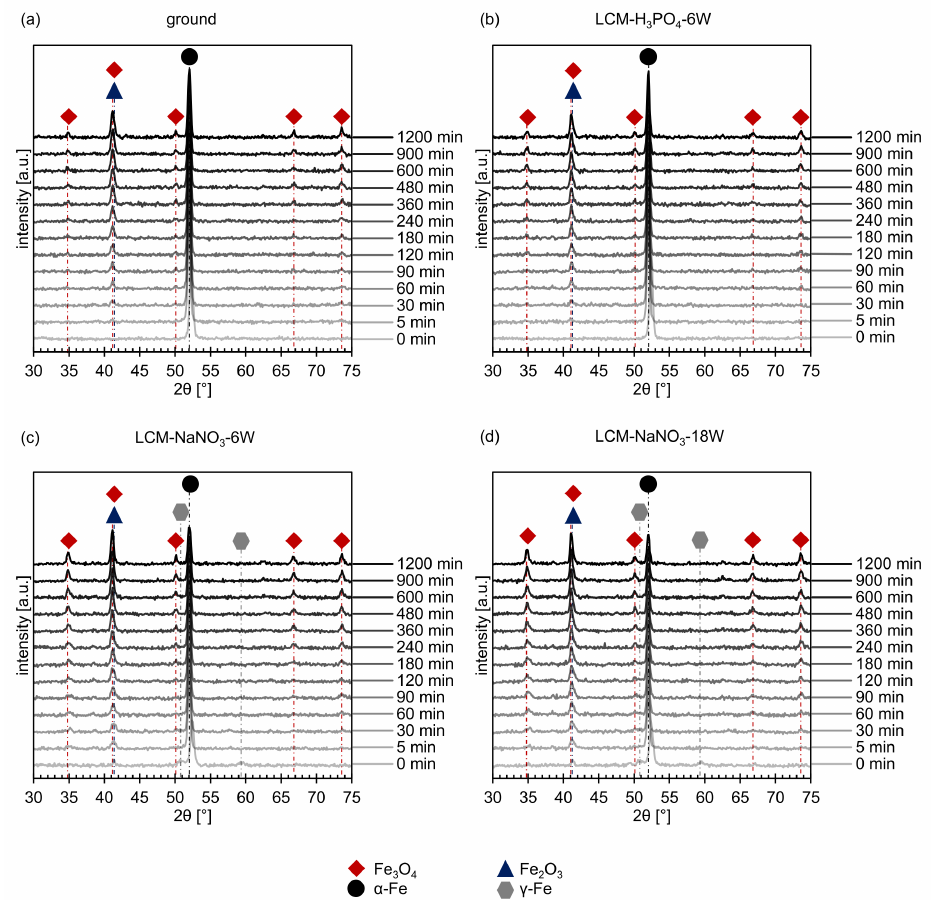
Figure 7. In situ XRD spectra of ( a ) ground, ( b ) LCM-H 3 PO 4 -6W, ( c ) LCM-NaNO 3 -6W and ( d ) LCM- NaNO 3 -18W 42CrMo4 steel at 500 ◦ C up to 20